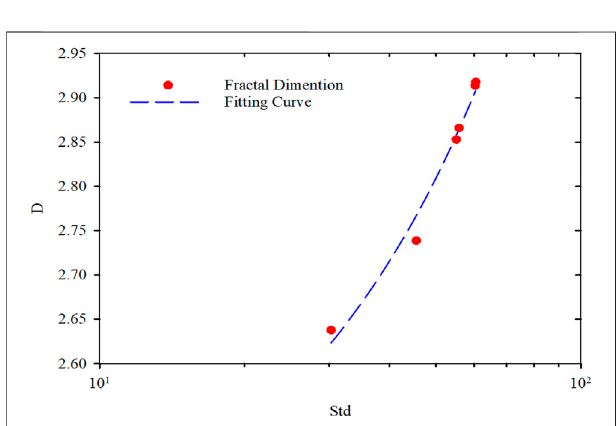
FIGURE 11 | Fractal dimension versus the average size of PMs.